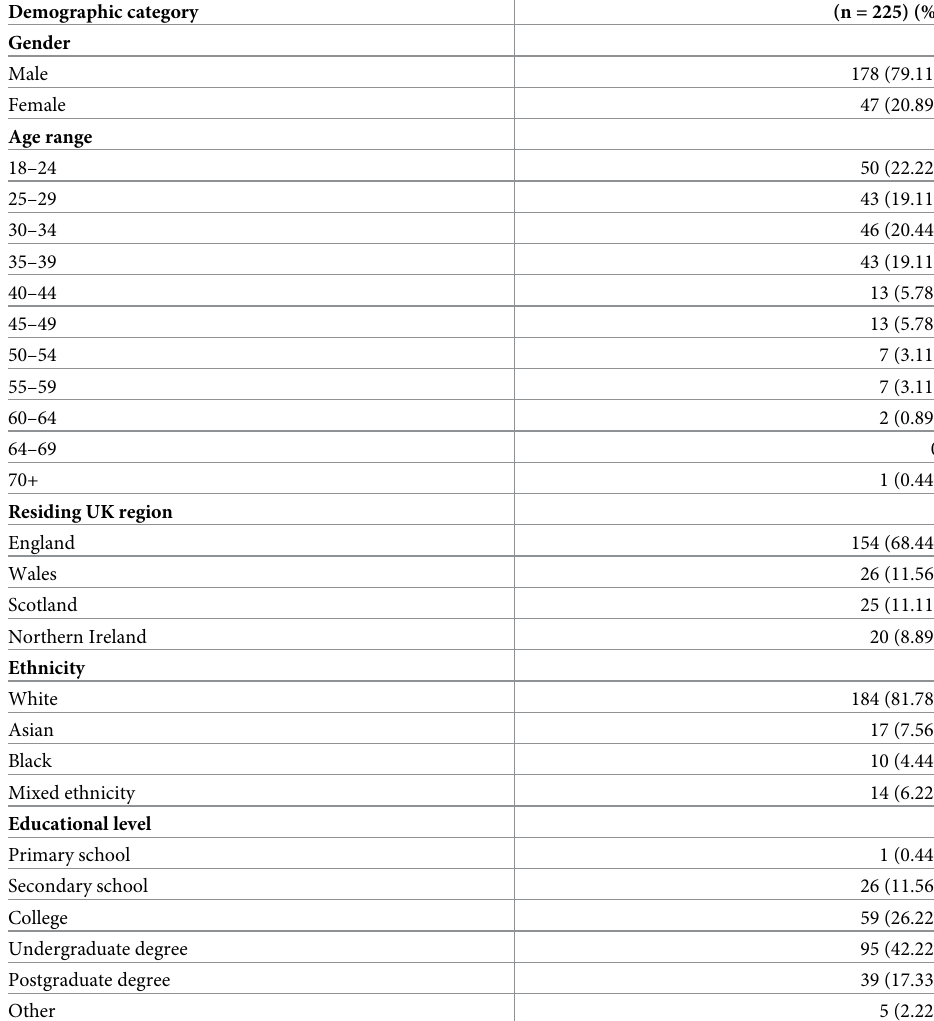
Table 1. Demographic characteristics of the